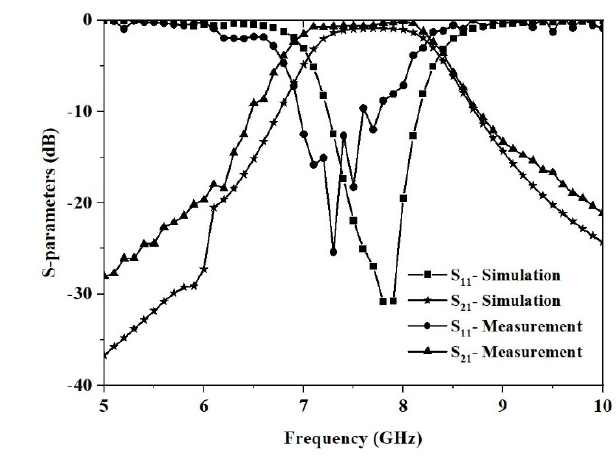
FIGURE. 13.C. TOP VIEW OF FABRICATED MOORE FRACTAL APPLIED SYMMETRICAL RING RESONATOR BANDPASS FILTER WITH MOUNTING BOX.